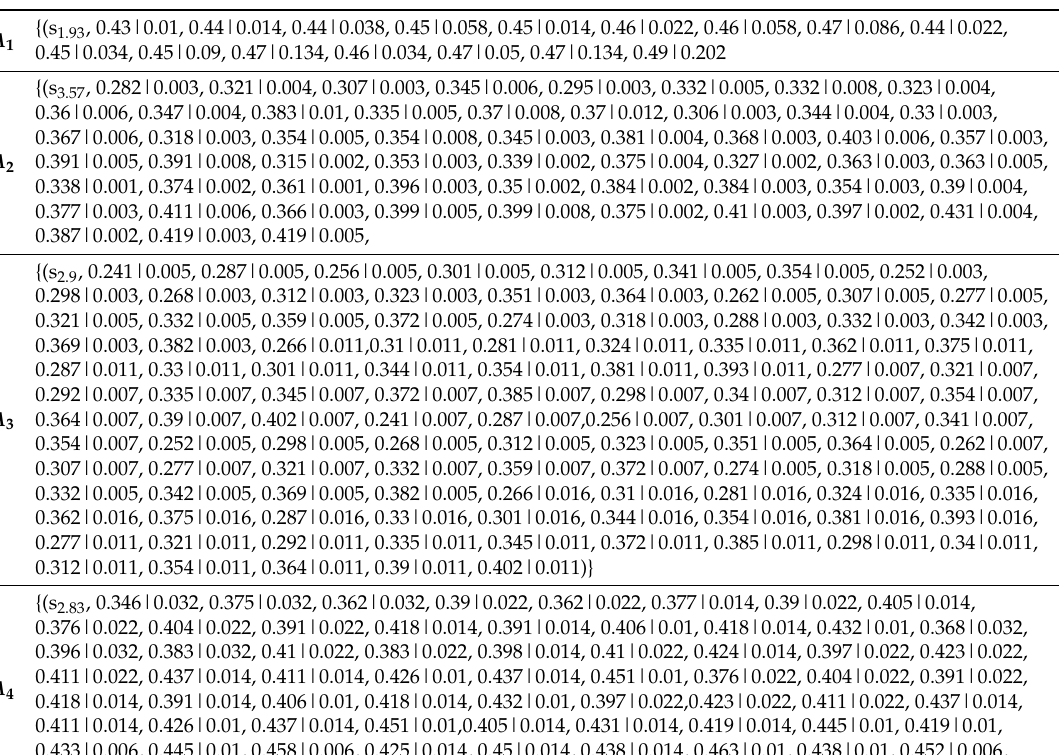
Table 6. Collective HPFLE group decision matrix using HPFLWA